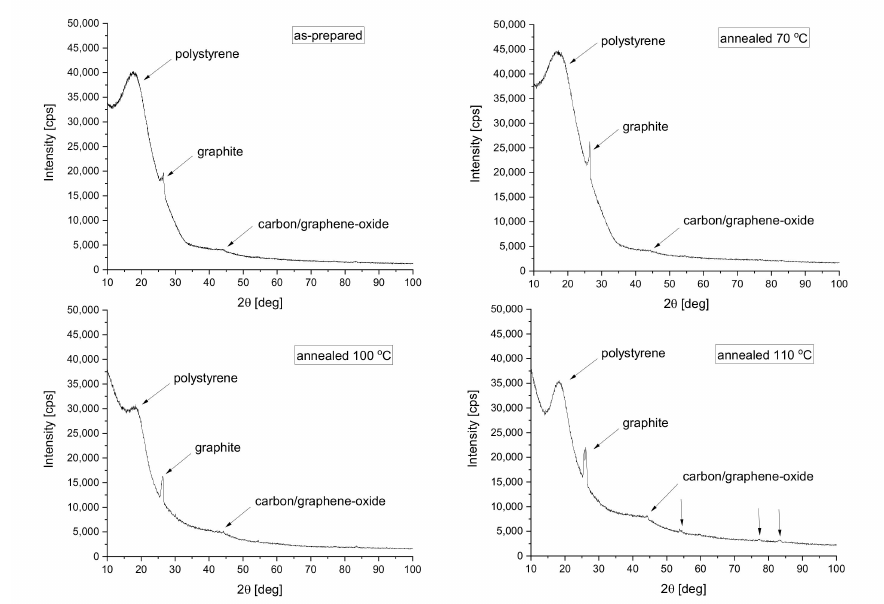
Figure 11. The X-ray diffractometer